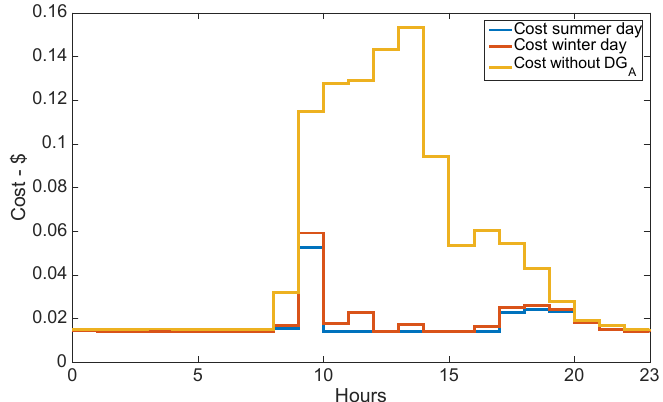
Figure 14. Energy cost of power with and without Distributed Generation (DG) on a summer day and a winter day.